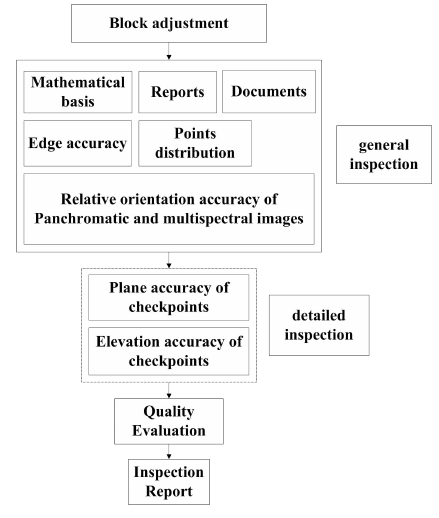
Figure 1. Block adjustment quality inspection technical